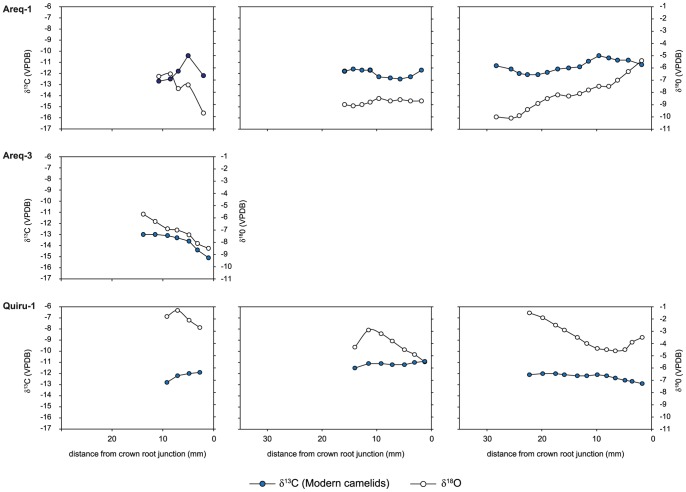
Intra-tooth isotopic composition of enamel structural carbonate of modern camelids.Intra-tooth variations in δ13C and δ18O values (‰ VPDB) measured along the molar crowns of modern highland domestic camelids and estimation of the contribution of C3 and C4 plants during crown growth. For each specimen, the left graph is for the M1 molar (except for Areq-3), the middle graph for the M2 molar and the right graph for the M3 molar. On each graph, the left axis refers to δ13Cenamel values and the right to δ18Oenamel values.